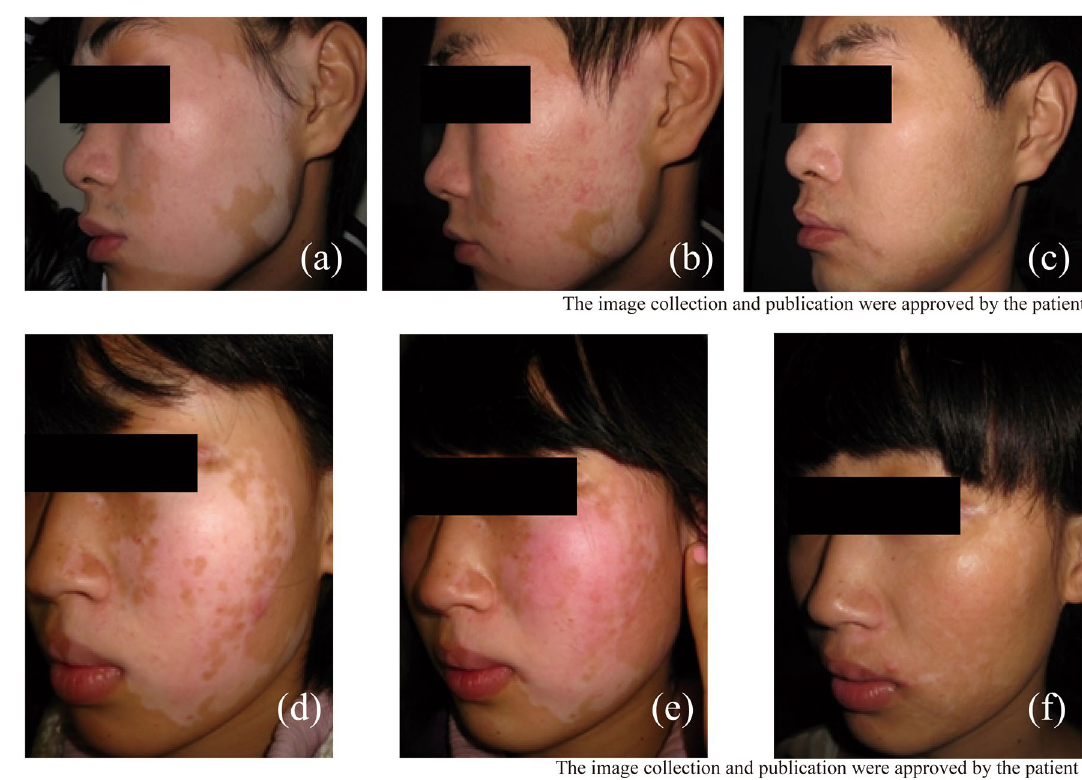
Figure 6. Vitiligo lesion in a 37-year-old patient ( a ) before and ( b ) 6 months after the transplantation of CMT. A0% repigmentation was achieved in the first transplantation. After treatment, a 98% repigmentation rate was achieved ( c ). Vitiligo lesion in a 22-year-old patient ( d ) before and ( e ) 6 months after the transplantation of CMT. A 0% repigmentation was achieved in the first transplantation. After treatment, a 95% repigmentation rate was attained in the re-transplantation ( f